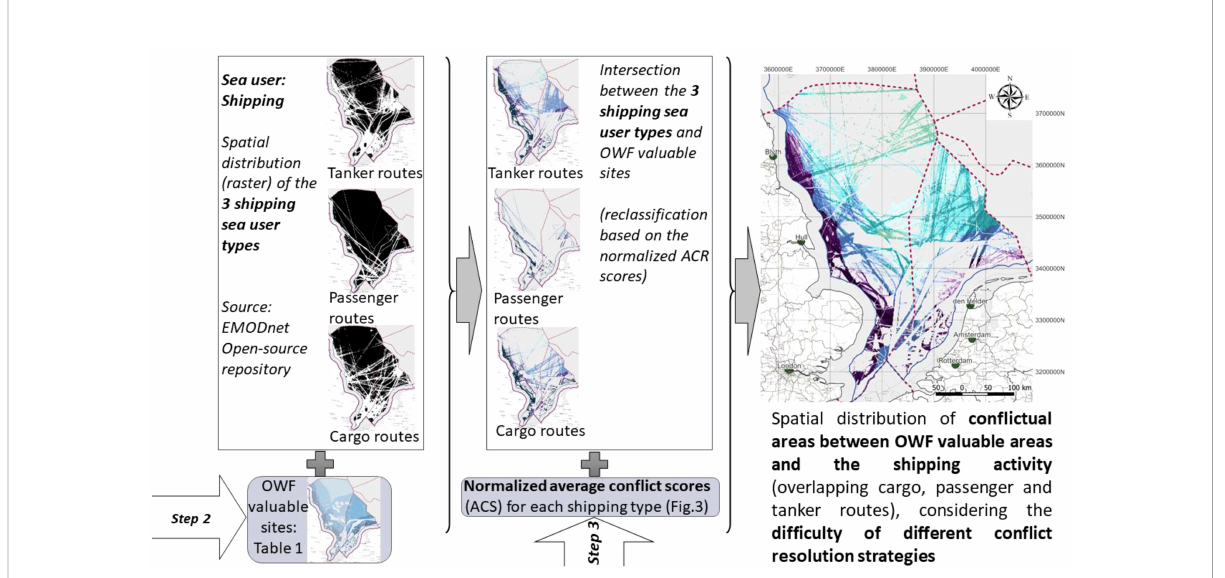
FIGURE 5 Sequence of steps to determine the average con fl ict resolution scores for each sea user type, based on the identi fi ed risks, con fl ict resolution strategies Supplementary Data 3) and respective con fl ict resolution ranks (Figure 4).